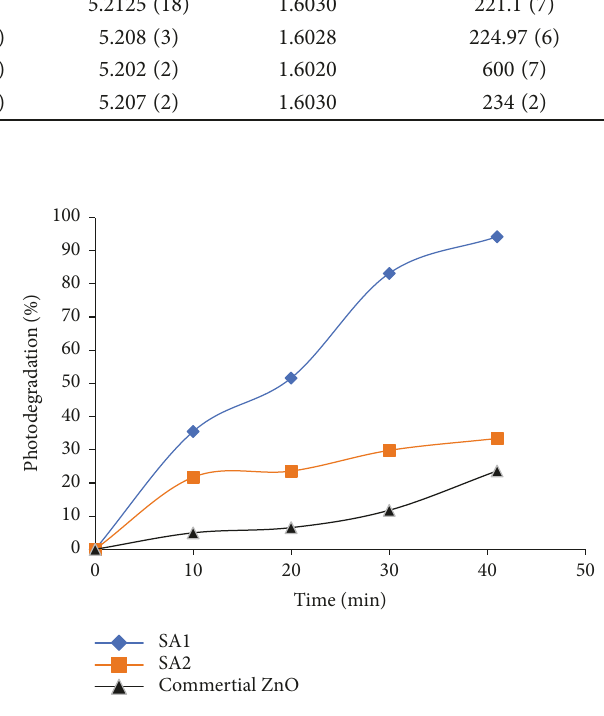
Figure 5: Variation of % of photodegradation versus time for various di ff erent ZnO catalyst (0.3 g) under